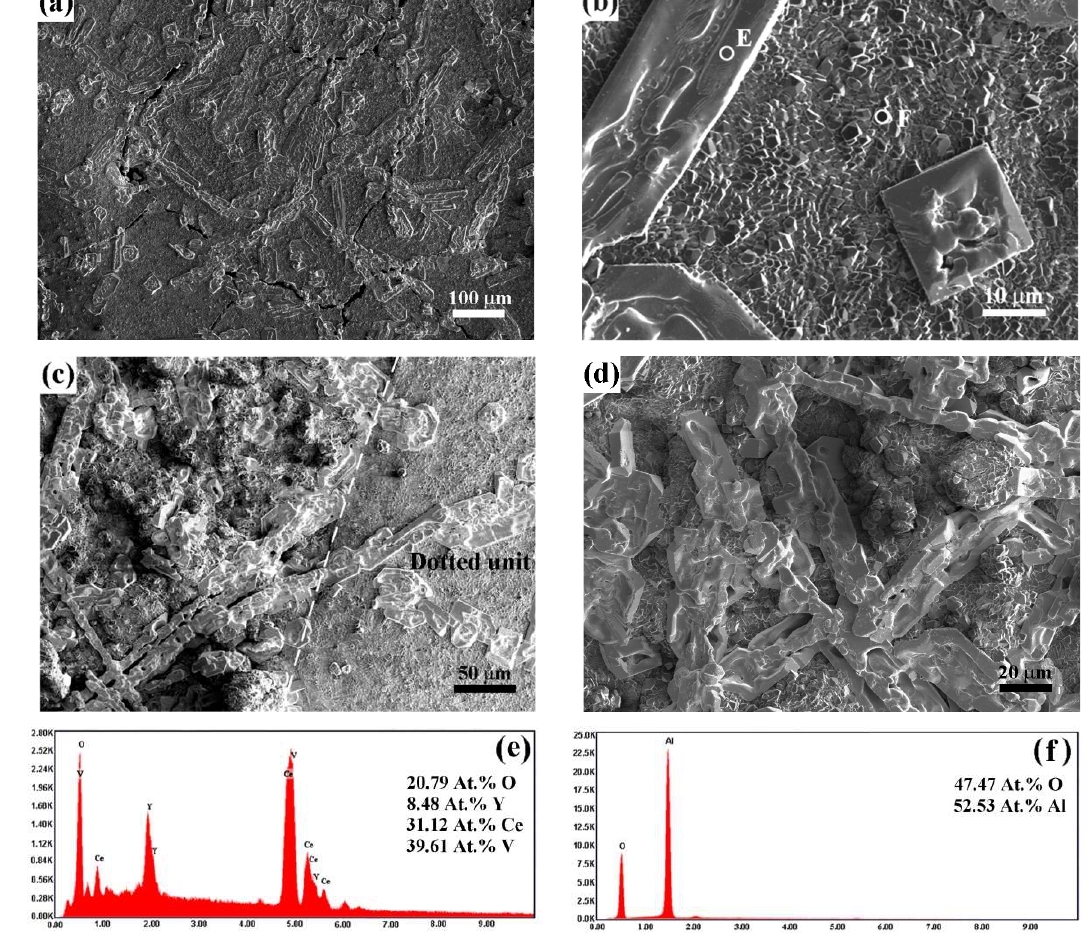
Figure 12. The SEM surface morphology of the DA coating after the hot corrosion test: ( a ) the dotted unit; ( b ) higher magnification of image ( a ); ( c ) the boundary of the dotted unit; and ( d ) the plasma-sprayed zone. EDS analysis of ( e ) Spot E and ( f ) Spot F.